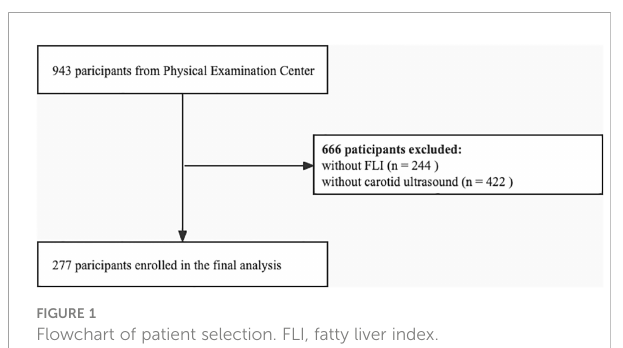
FIGURE 1 Flowchart of patient selection. FLI, fatty liver